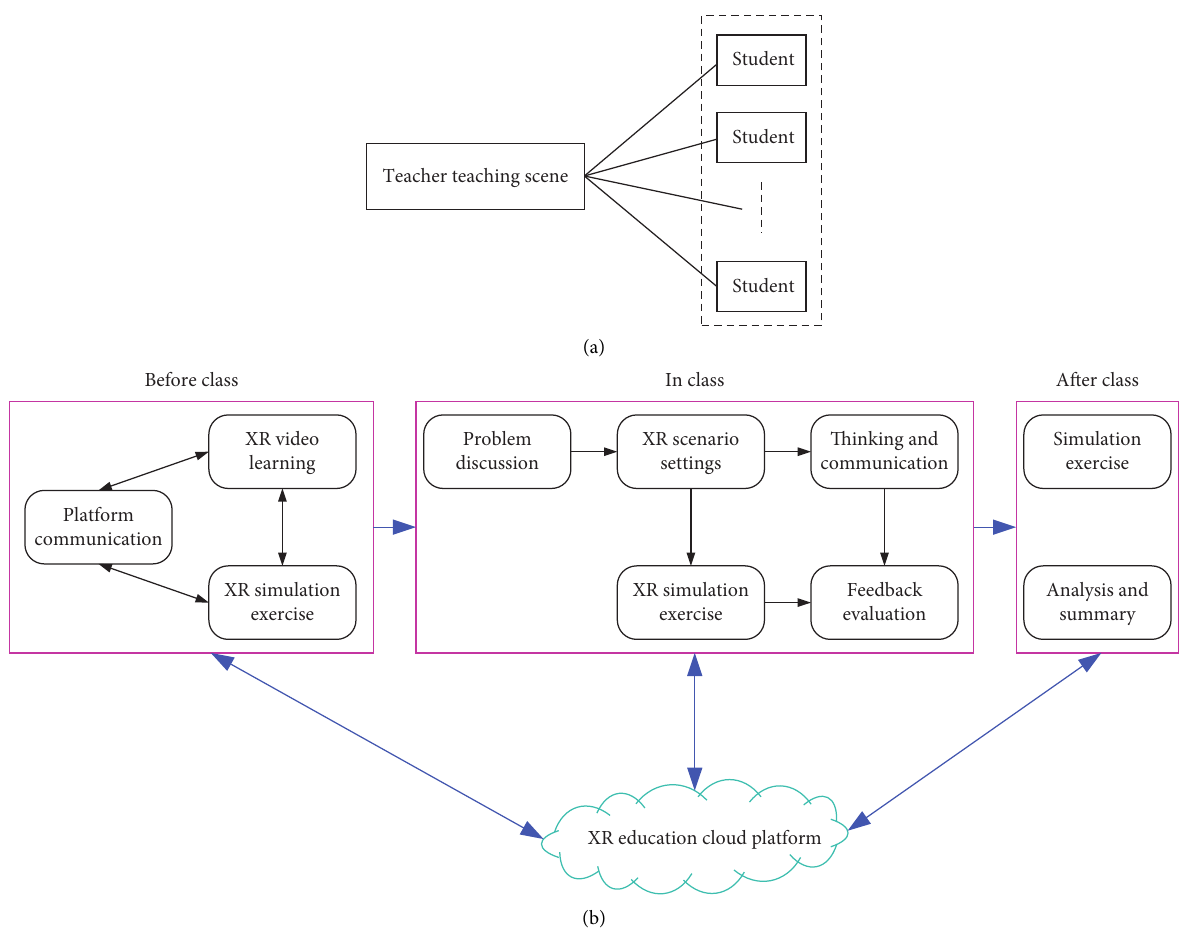
Figure 6: Construction of immersive XR teaching space. (a)Traditional teaching scene. (b)Immersive XR teaching